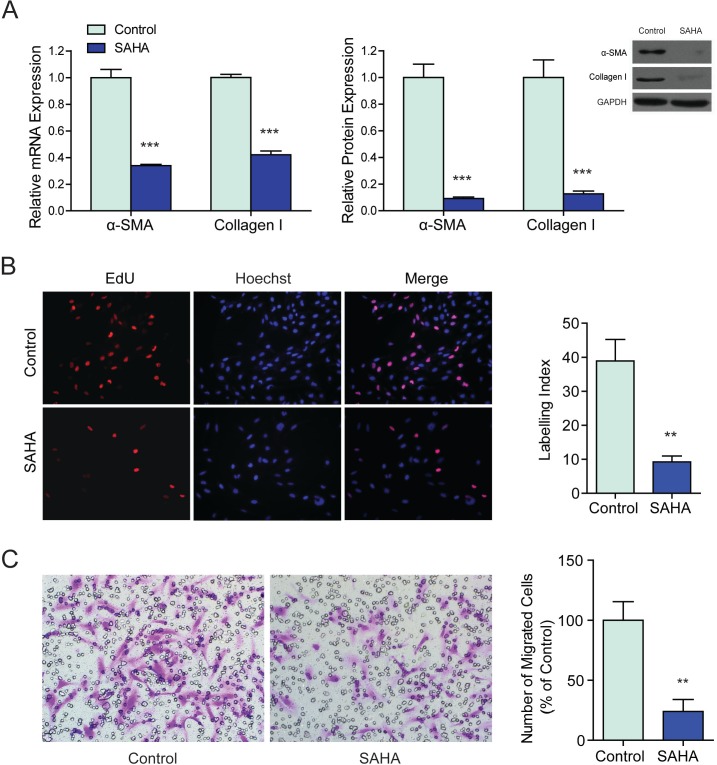
Suberoylanilide hydroxamic acid (SAHA) reversed the activation phenotype of a human hepatic stellate cell (HSC) line—LX2.(A) LX2 cells were exposed to 2.5 µM SAHA, the mRNA and protein expression of HSCs activation biomarkers (α-SMA and collagen I) were determined by real-time quantitative polymerase chain reaction and western blot, GAPDH was used as a loading control. (B) SAHA inhibited the proliferation of LX2 cells. EdU positive cells were detected by Alexa Fluor 594 azide (red); nuclei were counter stained with Hoechst 33258 (blue). Original magnification ×200. The EdU incorporation rate was expressed as Labeling Index according to the following formula: number of EdU positive nuclei × 100/number of total nuclei. (C) SAHA inhibited the migration of LX2 cells. Cells migrated through the transwell membrane were stained with crystal violet. Original magnification ×200. ∗∗P < 0.01, ∗∗∗P < 0.001, compared to the control.